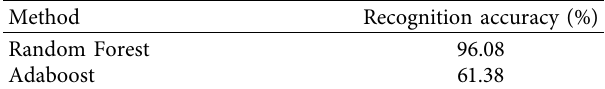
Table 3: Longitudinal motion behavior recognition test